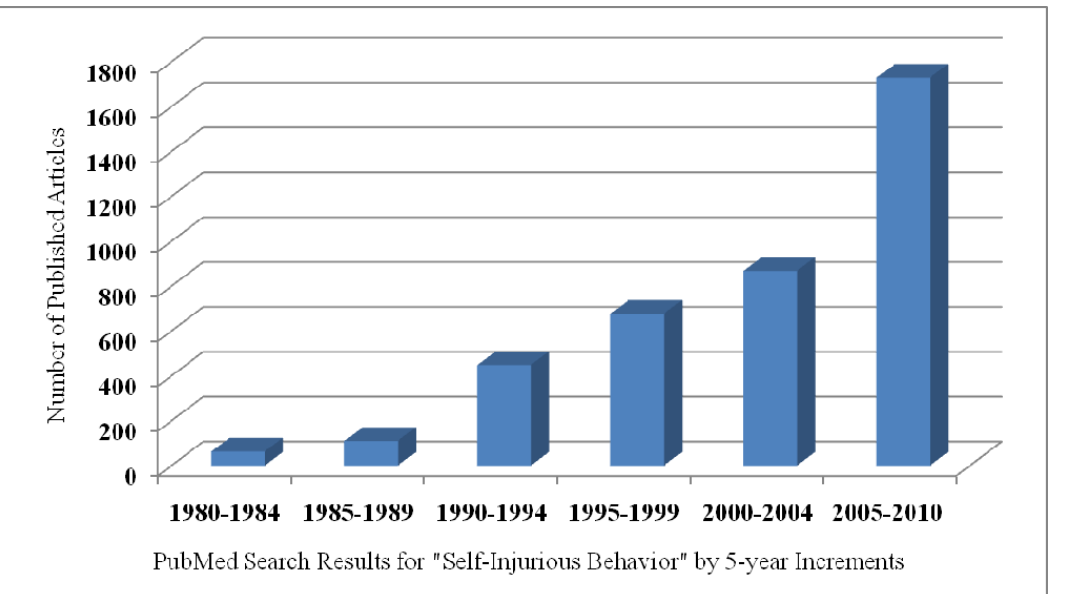
Figure 1. Number of studies of self-injurious behavior (SIB) conducted in 5-year intervals from 1980 to the